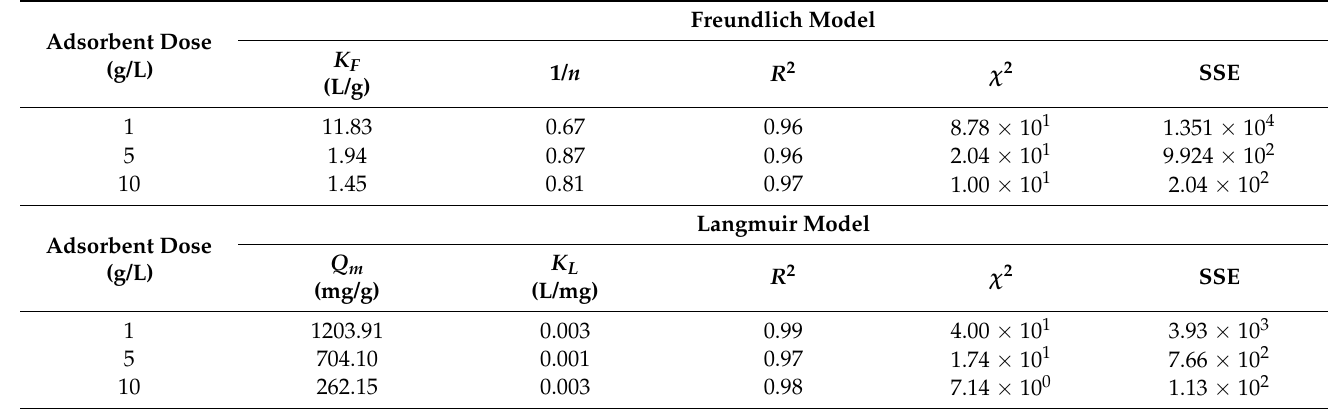
Table 5. Equilibrium isotherm model parameters obtained from model fitting to experimental data.